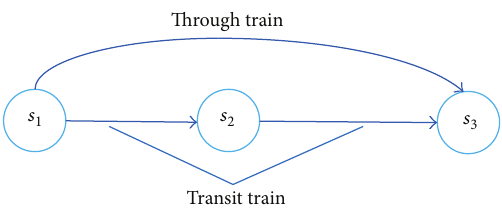
Figure 1: Illustration of express freight train